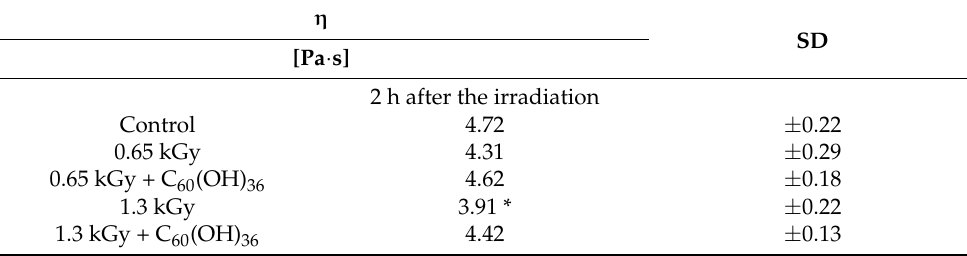
Table 1. η values determined with Tempamine use in a suspension of erythrocytes irradiated with 650 or 1300 Gy, incubated before irradiation with fullerenol at 150 µ g/mL for 1 h at 37 ◦ C and then irradiated with 650 and 1300 Gy. Measurements were taken 2 h after the irradiation. η SD [Pa · s] 2 h after the irradiation Control